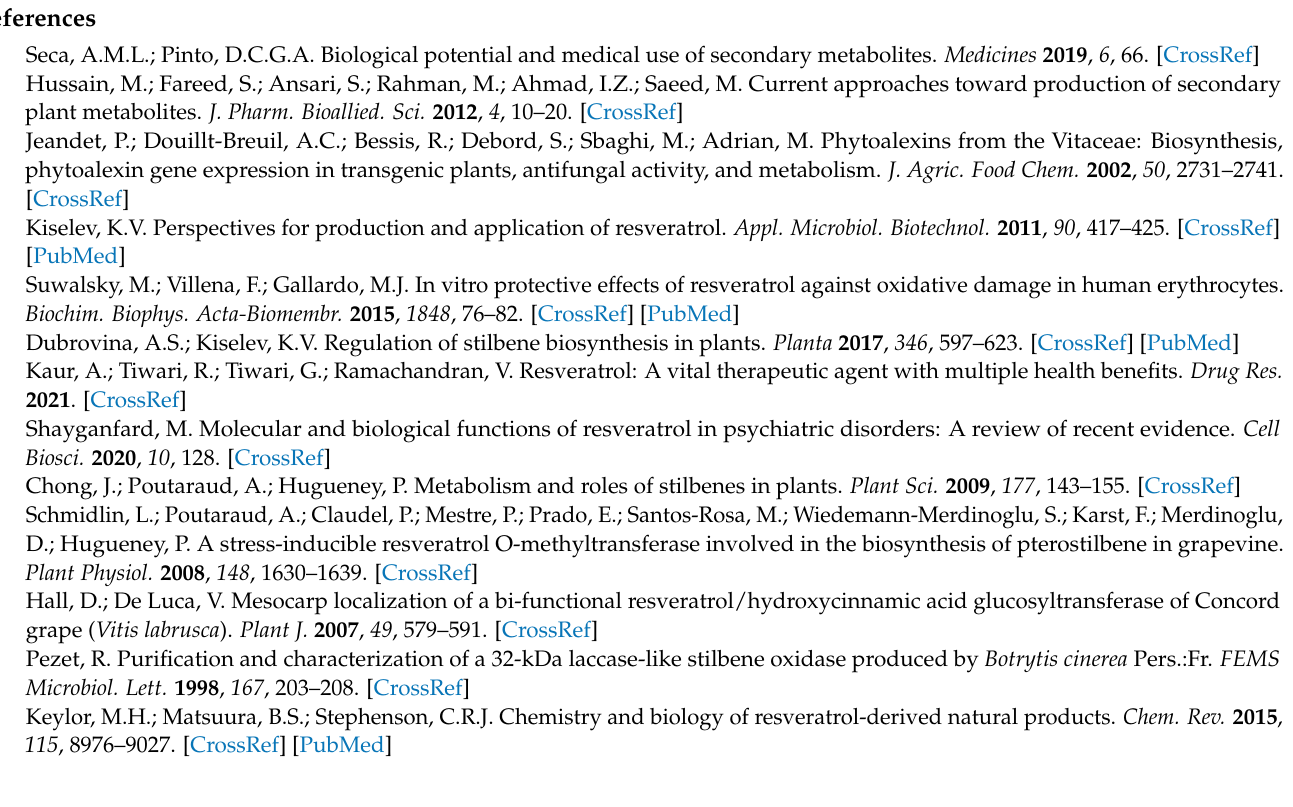
Table S1: List of the stilbene derivatives identified in the extracts of Picea jezoensis bark, Table S2: Resveratrol content before and after treatment by 60 ◦ C during 2